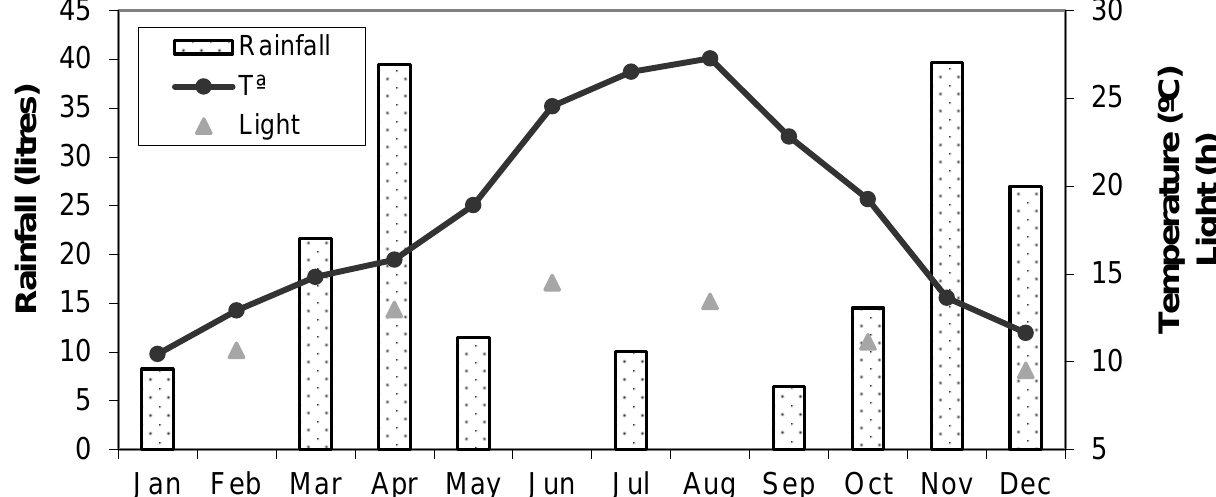
Figure 1. Environmental data in Almeria. Average monthly temperature from 2000 to 2001, rainfall from 2001 to 2002 and photoperiod from 2001, data obtained from Plataforma Solar de Almeria.